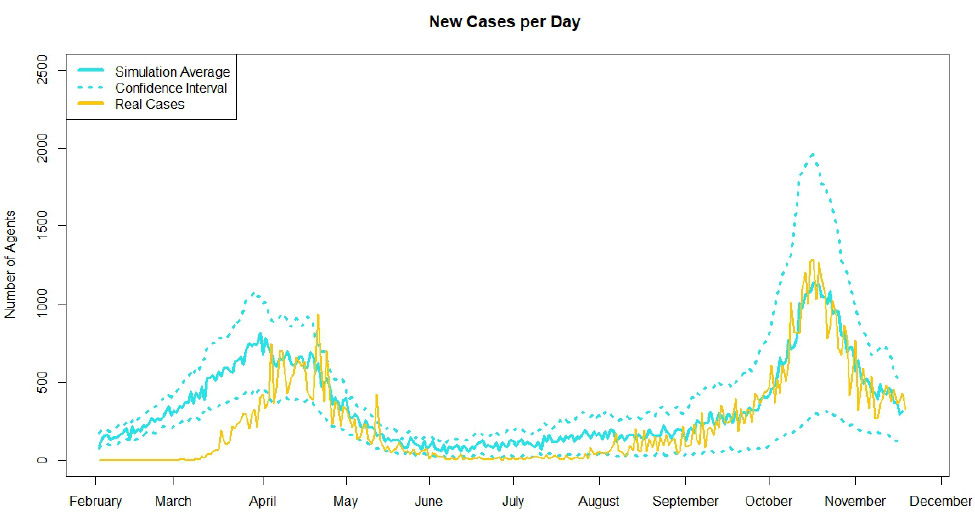
Figure 5. Plot showing the average simulated new cases per day across 30 runs in blue and the real Irish case counts in yellow. Upper and lower bounds of confidence intervals for the average simulated new cases are represented in blue dashed